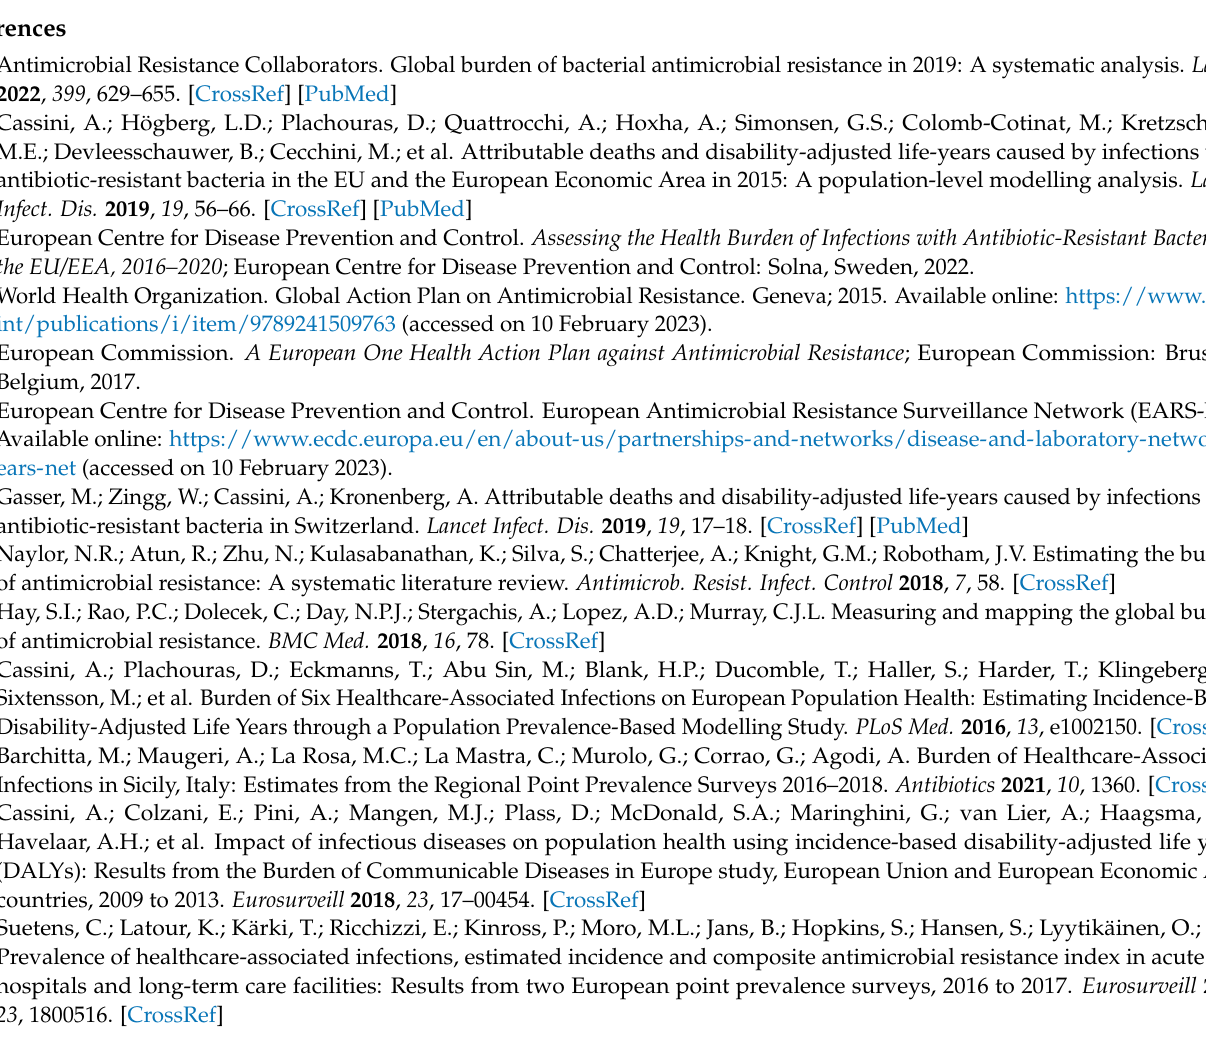
countries; Figure S5. Trends in population density between 2010–2019 across 30 European countries; Figure S6. Association of antimicrobial resistance (normalized) with antibiotic consumption (A) and population density (B); Figure S7. Trends in GDP per capita between 2010–2019 across 30 European countries; Figure S8. Trends in the governance index between 2010–2019 across 30 European countries; Figure S9. Association of antimicrobial resistance (normalized) with GDP per capita (A) and the governance index (B); Table S1. Unadjusted and adjusted multivariable analyses to evaluate the linear relationship of antimicrobial resistance with temperature change and other